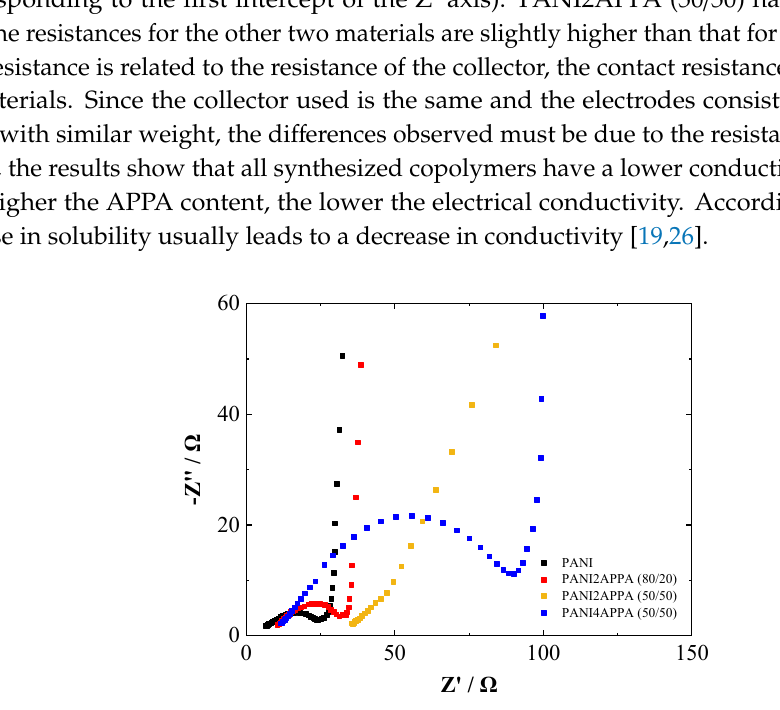
Figure 4. Nyquist plots of PANI (black dots), PANI2APPA feed ratio 80 / 20 (red dots) and 50 / 50 (orange dots), and PANI4APPA feed ratio 50 / 50 (blue dots) in 1 M HCl. Table 4. Internal resistance (R s ) of PANI, PANI2APPA, and PANI4APPA copolymers at 0.6 V in a 1 M HCl electrolyte obtained by Electrochemical Impedance Spectroscopy (EIS).